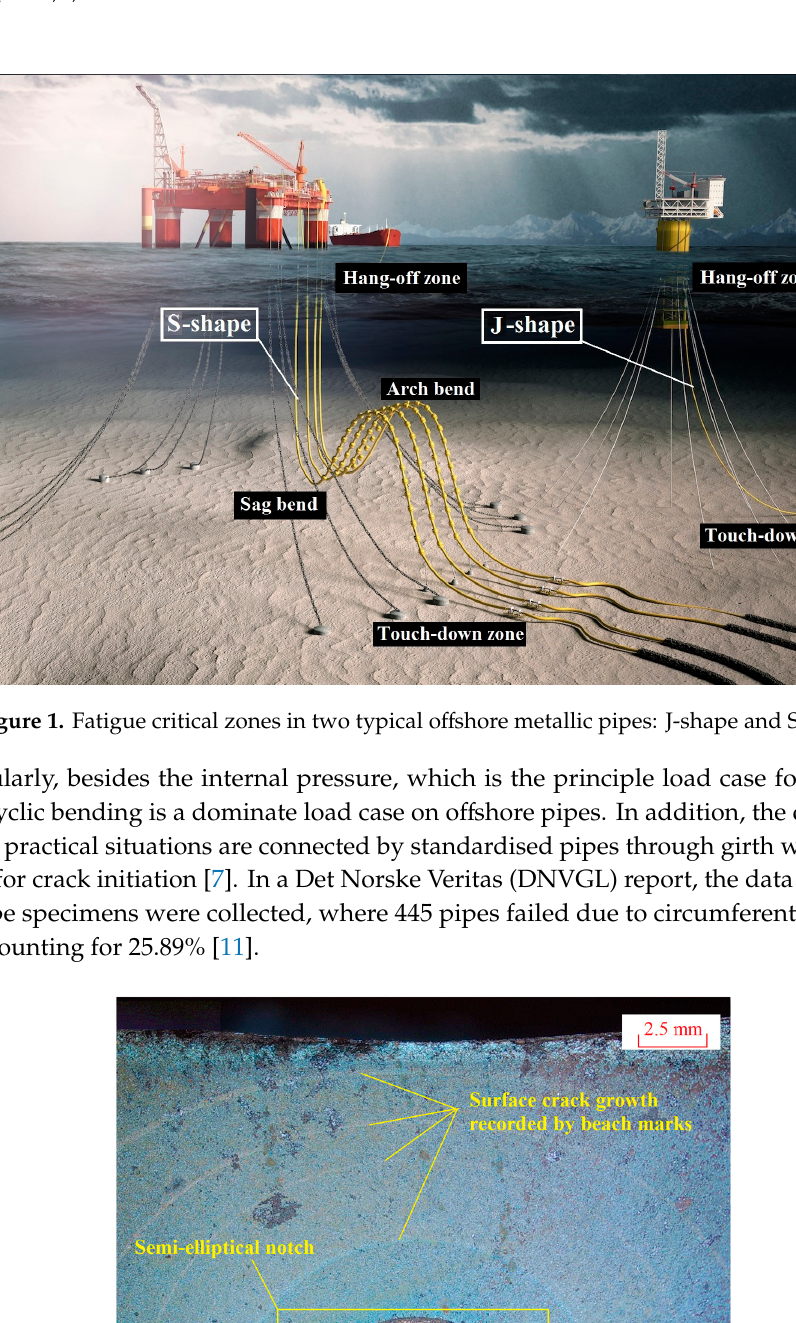
Figure 2. Circumferential semi-elliptical surface crack in metallic pipes, data from Ref. [12].